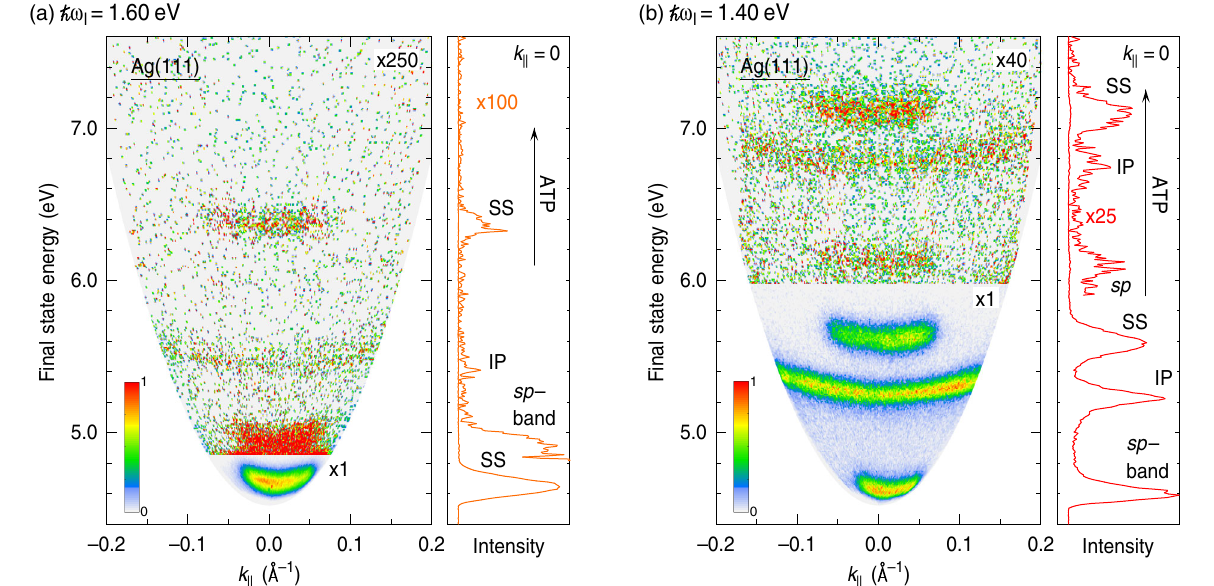
FIG. 5. Energy- and k k -resolved mPP spectra of Ag(111). Photon energies are chosen such that nonresonant excitation of the SS state is detected (a) by 3PP and (b) by 4PP; photoemission spectral features are labeled in the line profiles taken at k k ¼ 0 , and excitation diagrams are given in Fig. 1(a). ATP contributions show replicas of states observed in 3PP and 4PP but translated upward by one photon energy. (a) The photoemission spectrum excited with ℏ ω l ¼ 1 . 60 eV has a dominant contribution from the SS state excited by 3PP and weaker contributions from the first IP state and the direct sp -band transition, which are detected in 4PP. The ATP feature attributed to m ¼ ð 3 þ 1 Þ excitation is found approximately 1.60 eV above the 3PP SS state peak. (b) For ℏ ω state, and the direct sp -band transition are detected in 4PP. At higher final state energies, their replicas appear in ATP through m ¼ ð 4 þ 1 Þ